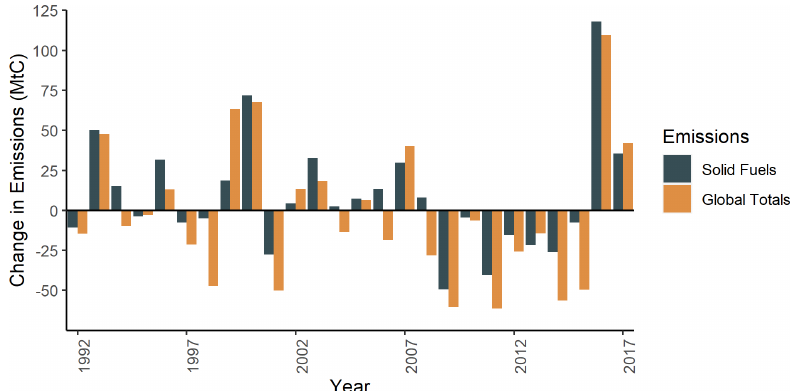
Figure 1. The change in estimated global total CO 2 emissions by including changes in stocks as opposed to just using production data, in megatons of carbon (MtC). In 2016, the change in global total emissions (orange) corresponds to a 1.10% underestimation of emissions if drawdown of stocks is not included in the calculation of global total emissions. This is mostly attributable to changes in stocks of solid fuels (purple), where including the change in stock results led to an increase of 3.15% in emissions from solid fuels. Negative values indicate that there was an increase in stocks on hand and that CO 2 emissions would be overestimated if stock changes were not included. We concluded that data on changes in stocks were sufficiently comprehensive to be included in calculations of CO 2 emissions after